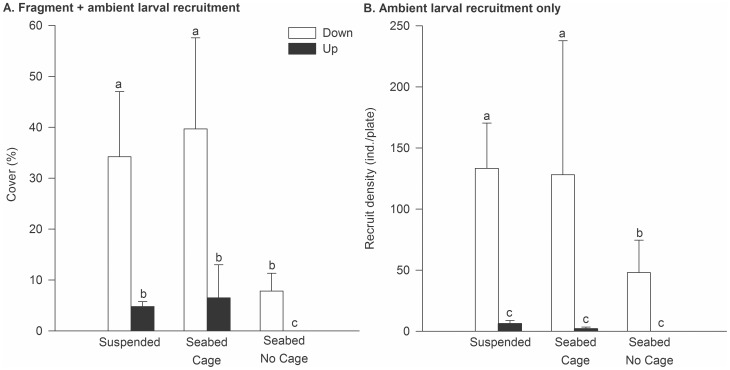
Establishment of Didemnum in suspended and seabed treatments in summer 2008 at Blackwood Bay.Perspex plates were positioned in face-up and face-down orientations, with the seabed treatment including a Cage and No Cage comparison. All plates were exposed to larval recruitment from a floating pontoon approximately 25 m away, for a three month experimental duration. A). Mean Didemnum cover (% cover ±1SE) on plates inoculated with Didemnum fragments. B). Mean density of Didemnum recruits (±1SE) on plates subjected only to ambient larval supply. Different letters (a,b,c) indicate significant differences as indicated by the PERMANOVA post-hoc t-test.